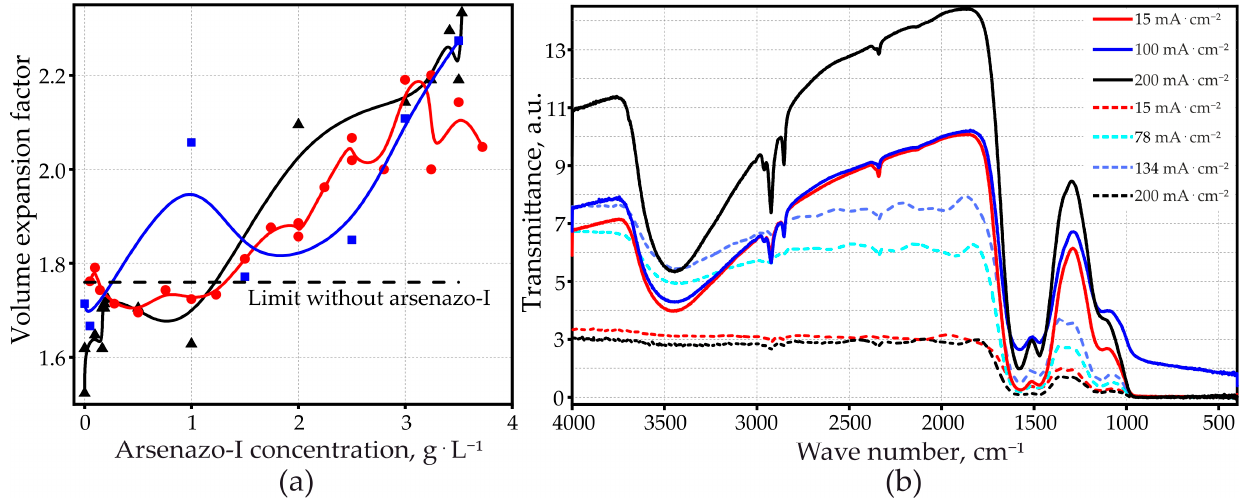
Figure 6. ( a ) Volume expansion factor, as a function of arsenazo-I concentration for Al in 0.6 M malonic acid; FTIR-spectroscopy: malonic acid without arsenazo-I, j a = 15, 78, 134, 200 mA·cm − 2 (dashed lines); ( b ) malonic acid with 3 g·L − 1 arsenazo-I, j a = 15, 100, 200 mA·cm − 2 (solid lines).